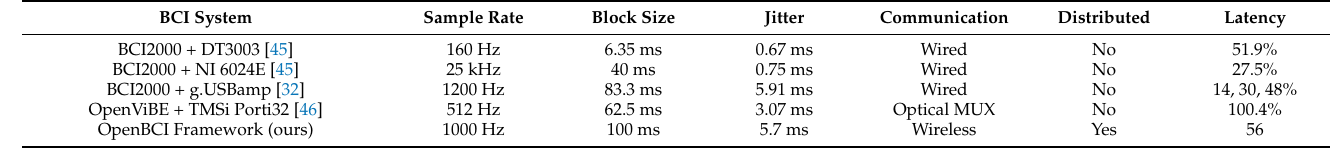
Figure 11. Latency vs. Block size results. Left : latency is proportional to the block size for small size values. Right : latency decreases for small block sizes but their standard deviation (jitter) increases for larger ones. The preferred configuration was set up in 100 samples block size due to the lower jitter. Table 6. Latency analysis for method comparison results. Latency has been expressed in terms of the percentage of the block size to make possible the comparison between different